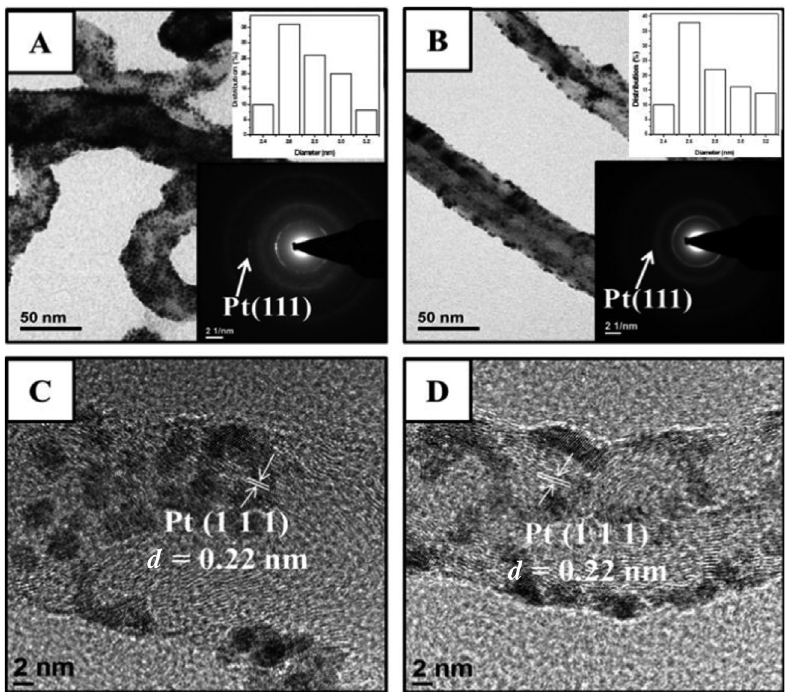
Figure 1 . TEM images (A and B) and HRTEM images (C and D) of Pt/[BMIM][PF 6 ]/CNT and Pt/[BMIM][Cl]/CNT nanohybrids. Inset to (A) and (B): their corresponding SAED patterns and the histograms of Pt particles size